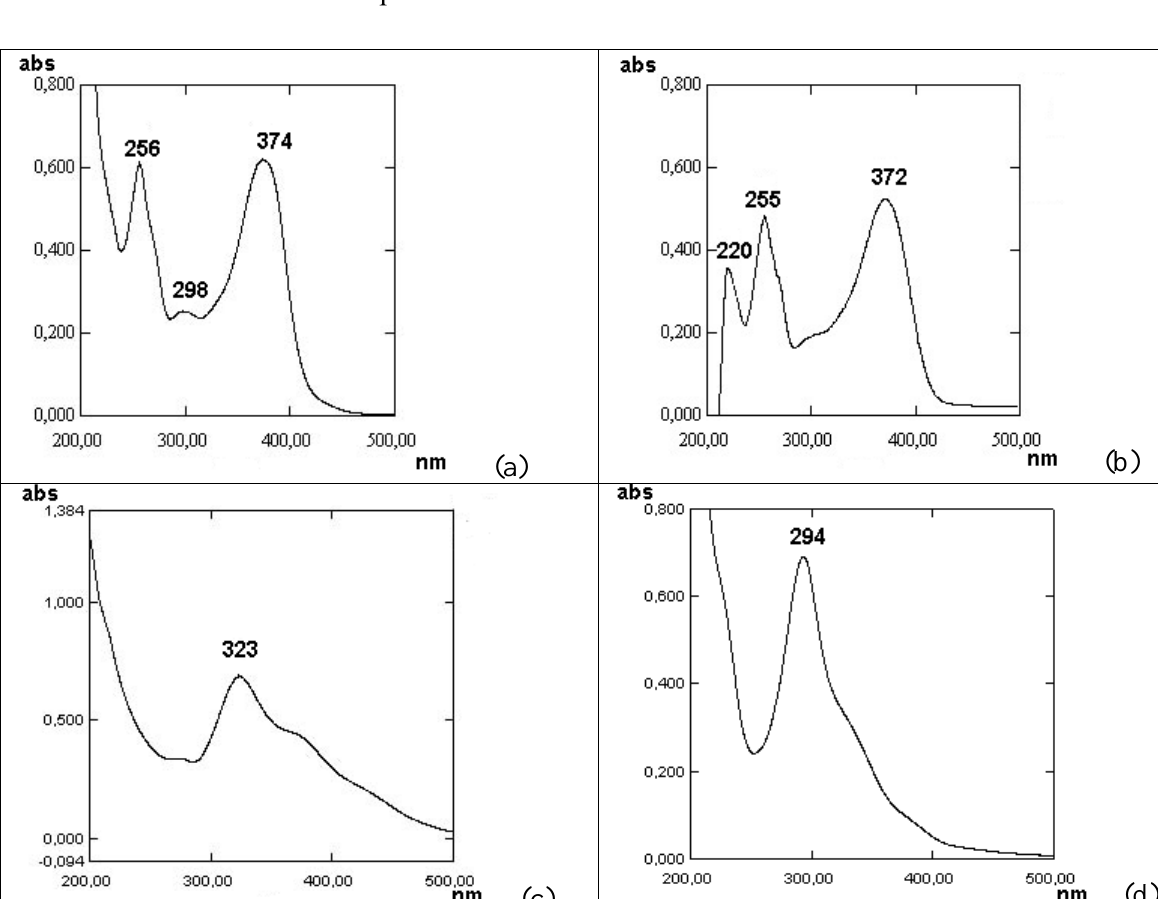
Figure 2. Variations of the UV-spectra of a water-ethanol solution of quercetin during its slow stepwise titration by NaOH within pH range 2-10, followed by the acidification up to pH = 4; (a) – UV-spectrum of quercetin in ethanol solution; (b) – at рН = 2; (c) – at рН = 10; (d) – UV-spectrum of solution after acidification to рН =